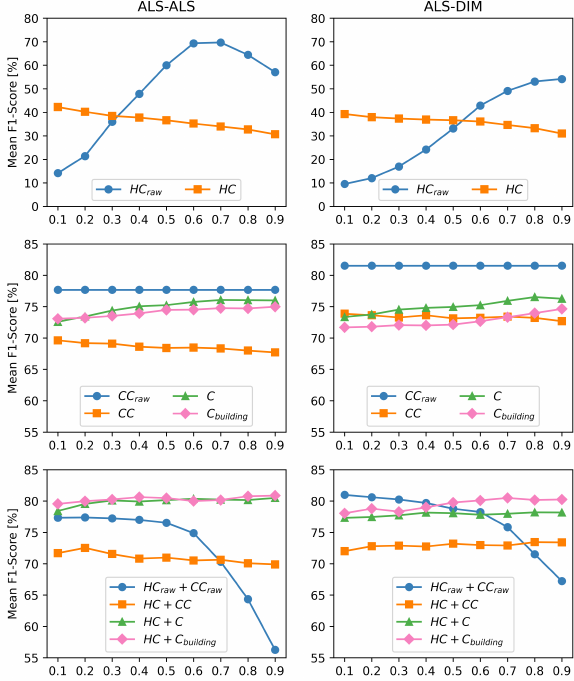
Figure 4. Mean F 1 -Scores on object-level for all input types depending on threshold τ for ALS-ALS and ALS-DIM